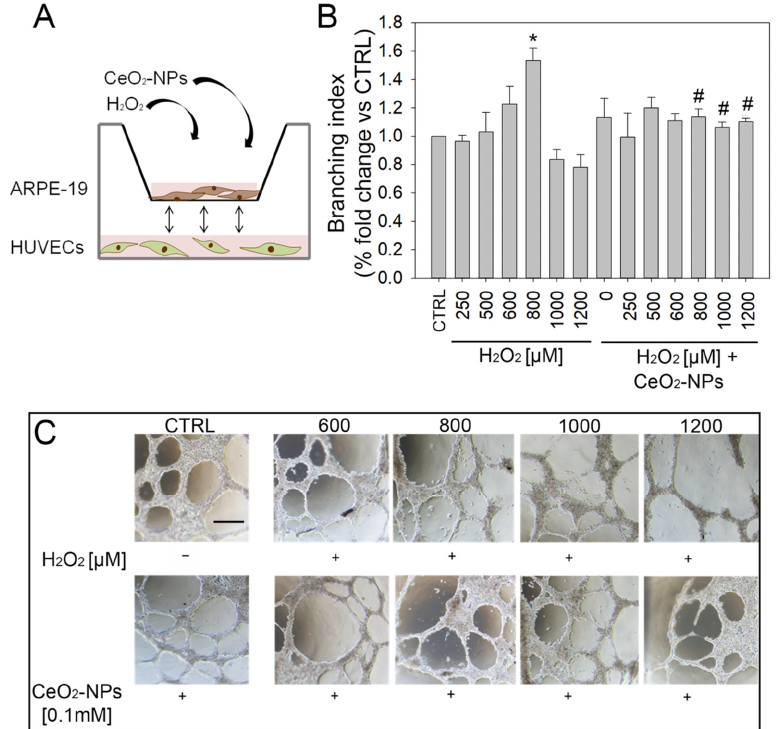
Figure 8. Effects of H 2 O 2 on a modified co-culture (ARPE-19-HUVECs) tubule formation in vitro. ( A ) Schematic representation of experimental workflow. ( B ) Tubule formation in co-cultured HUVECs with ARPE-19 cells treated with H 2 O 2 (250, 500, 600, 800, 1000, and 1200 μ M) or with H 2 O 2 plus CeO 2 -NPs (0.1 mM). ( C ) Representative images of tubule formation in different experimental